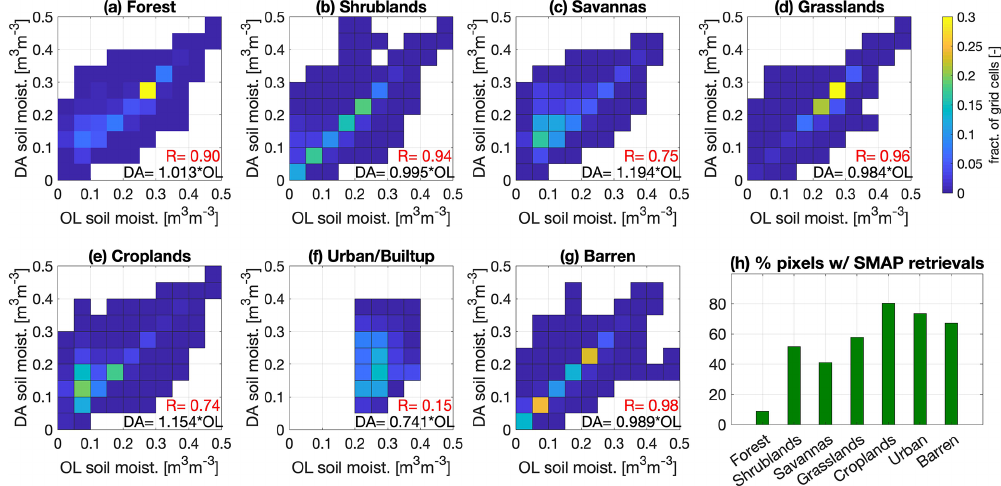
Figure 5. Comparison of OL- versus DA-NoCDF-estimated soil moisture according to the dominant land cover types present within the study domain. The OL and DA-NoCDF joint PDFs (presented here as fractions of grid cells) are computed from the LIS runs with MERRA2 boundary conditions during the winter months of WY